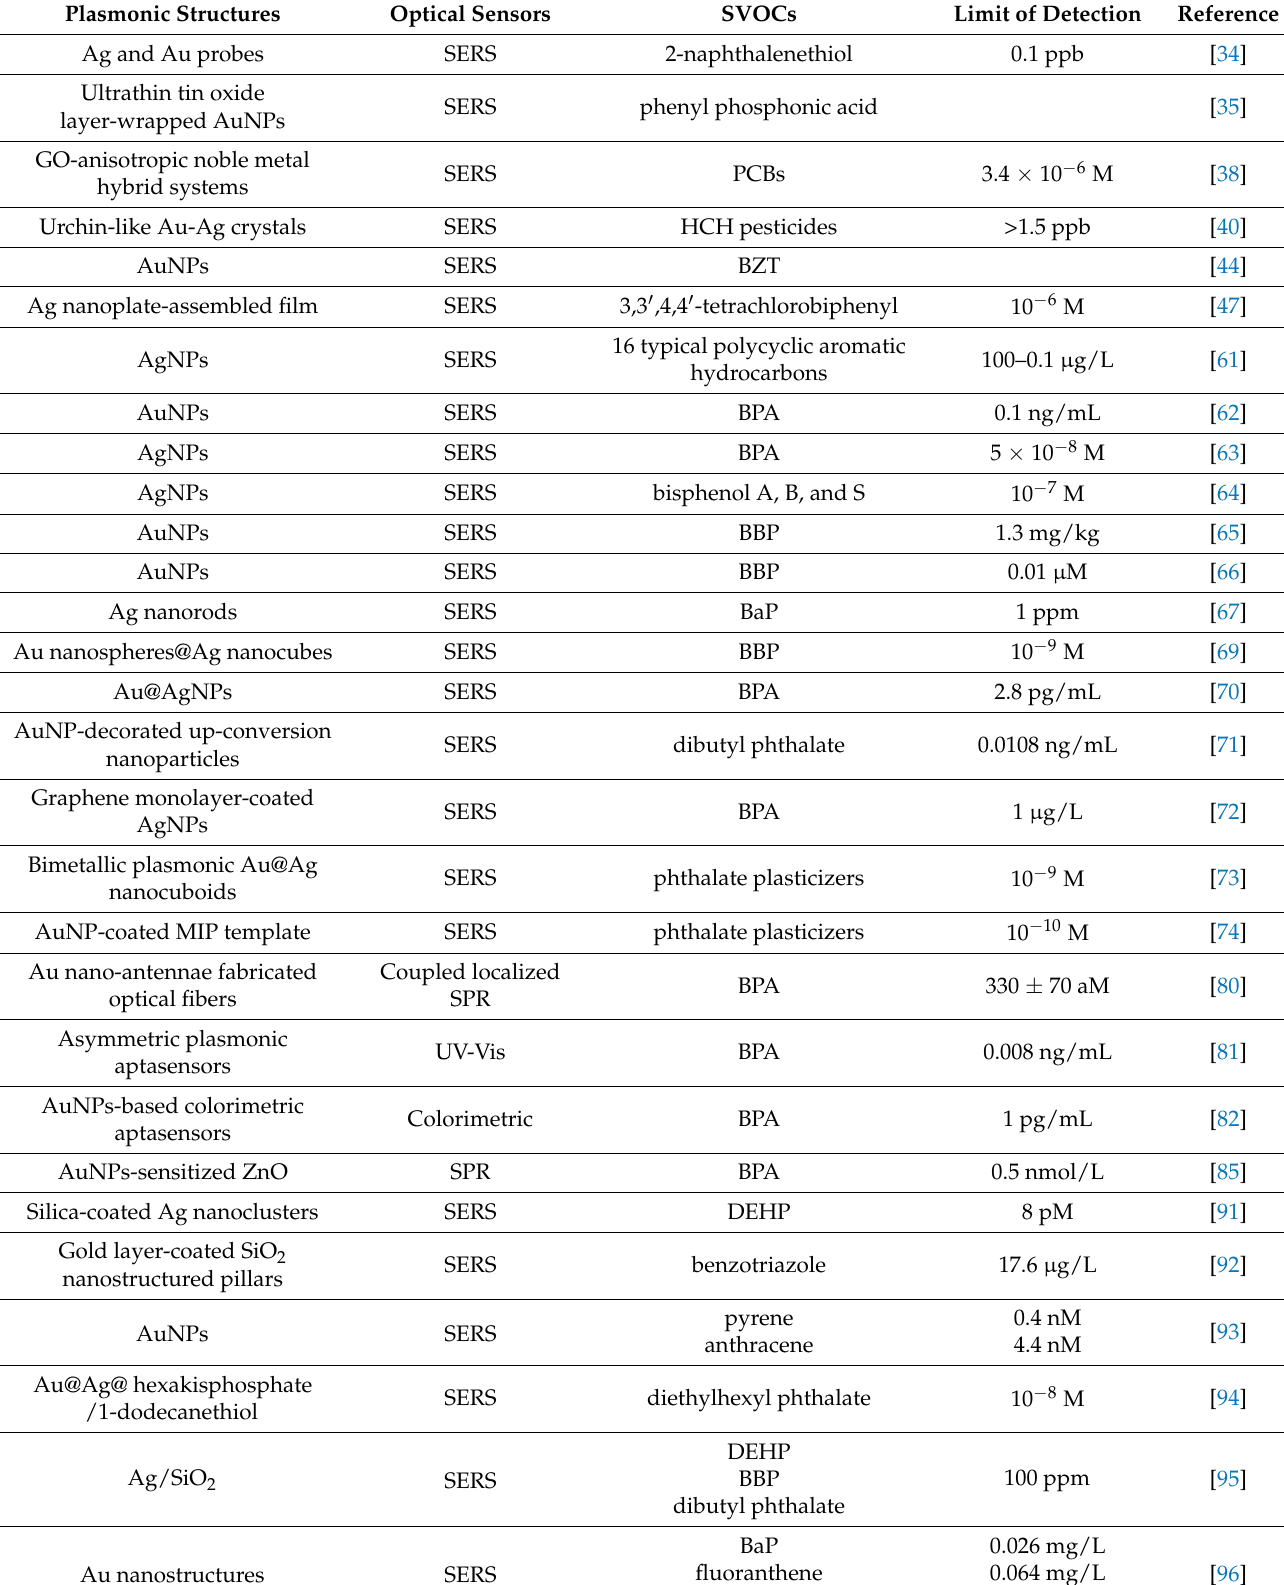
Table 1. Performance of plasmonic resonance-based optical sensors for detection of indoor